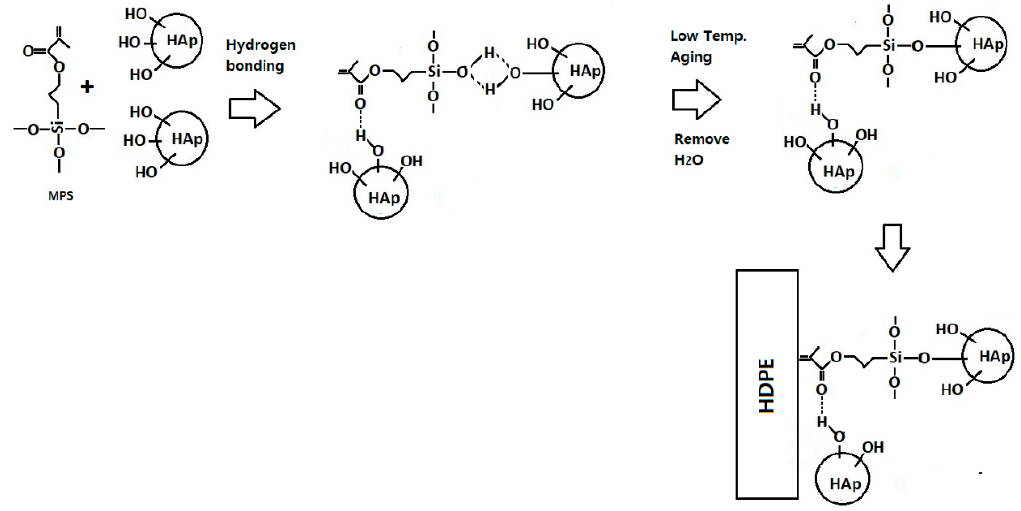
Figure 3. Schematic diagram representing the possible interaction mechanism reaction of silane coupling agent (MPS) interlinked with HAp surface treatment and HDPE matrix.